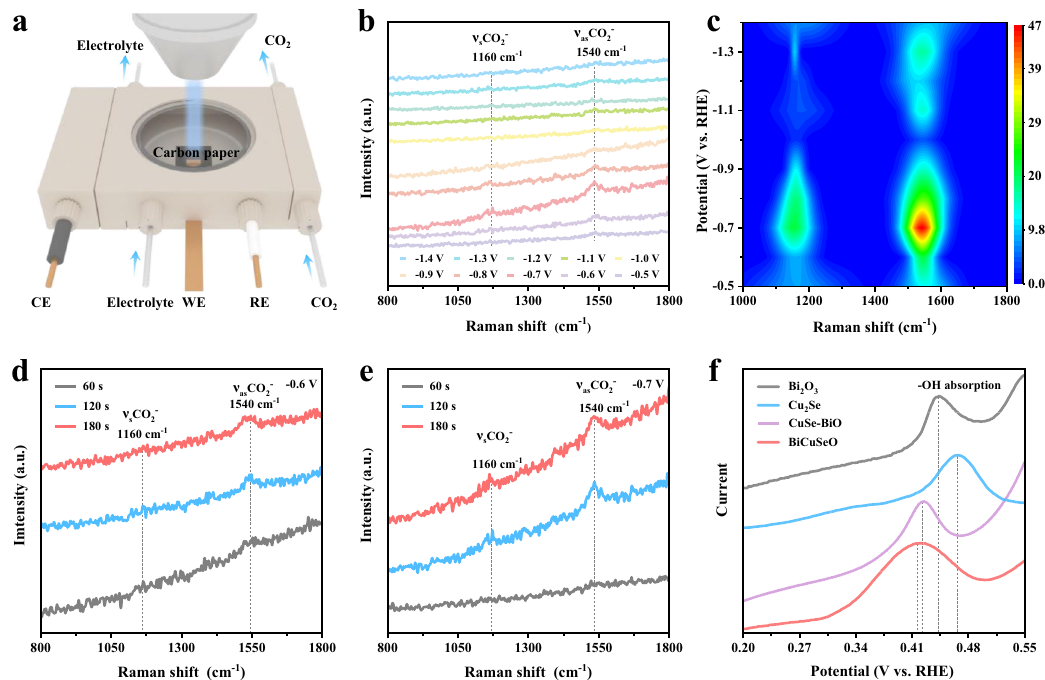
Fig. 3 Intermediates detection on BiCuSeO during CO 2 RR. a Schematic illustration of the in situ Raman measurement device during the CO 2 RR. b , c Potential- dependent and d , e time-dependent in situ Raman spectra of BiCuSeO catalysts in 0.5 M KHCO 3 solution under CO 2 bubbling. f Single oxidative LSV scans in N 2 -saturated 0.1 M NaOH solution for BiCuSeO, Cu 2 Se, Bi 2 O 3 Ns, and (Supplementary Fig. S12a, Table S4) 45 – 47 . Meanwhile, the peaks located at 1540 cm − 1 are vibrational fi ngerprints of asymmetric C – O stretching vibration modes of proton-trapped carboxylate ˙ − radicals (OCHO * , Supplementary Fig. S12b, Table S5) 45 – 47 . * CO 2